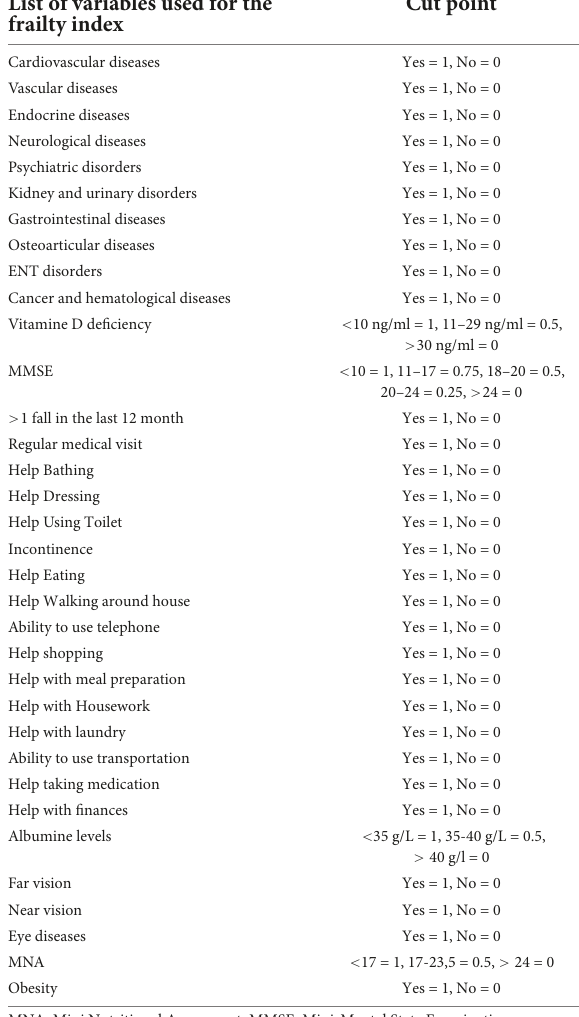
TABLE 1 List of variables and cut point used for the Rockwood index. List of variables used for the frailty